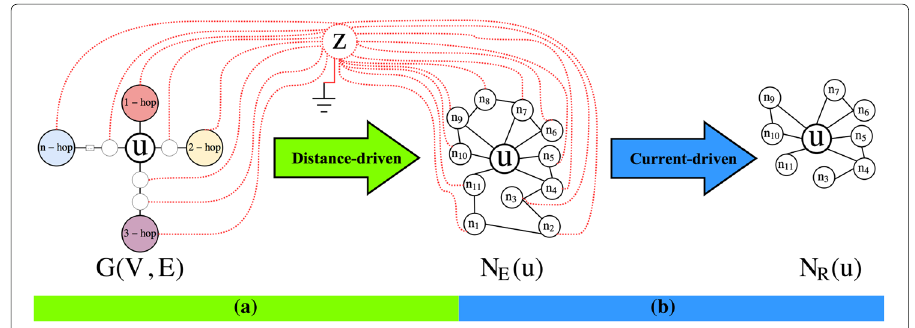
Fig. 1 A description of SURREAL algorithm neighborhood definition step main phases: ( a ) Neighborhood expansion of node u through n − hop neighbors to generate N E ( u ) on distance basis. Node z indicates the grounded universal sink node. ( b ) Neighborhood refinement of N E ( u ) to generate N R ( u ) on current